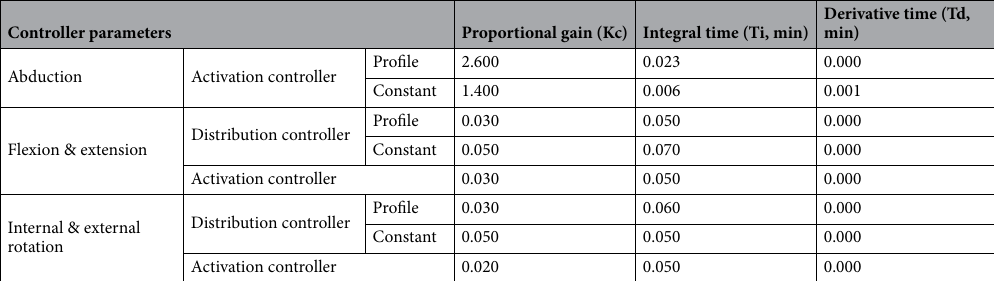
Table 2. Parameters of all PID controllers in the